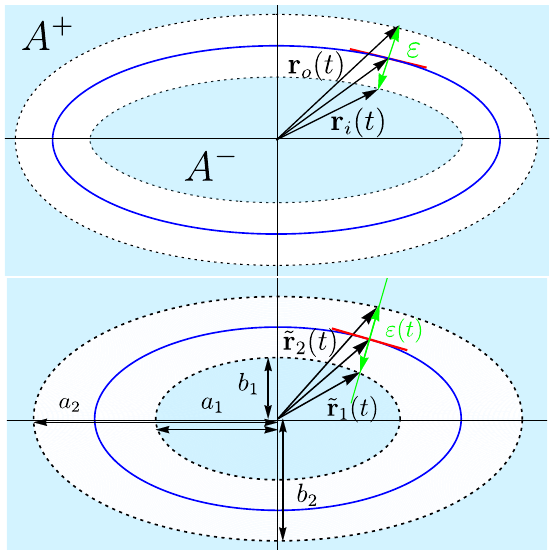
Figure 3 . (Left) We plot an example of the geometric setup required for the evaluation of the EE for an elliptic region A (solid blue curve) using the MI of an inner region A − and the complement of one which contains it, A + , as in (3.20). In this case, the inner and outer regions are defined so that ε is constant for all values of t . The points r i ( t ) and r o ( t ) are determined by moving a distance ε/ 2 inwards and outwards respectively from each point of ∂A . (Right) We show an alternative setup for which A + and A − are both elliptic regions, which forces ε ( t ) to be variable. The points ˜ r 1 , 2 ( t ) are determined from the intersection of the normal to ∂A at a given point with the inner and outer